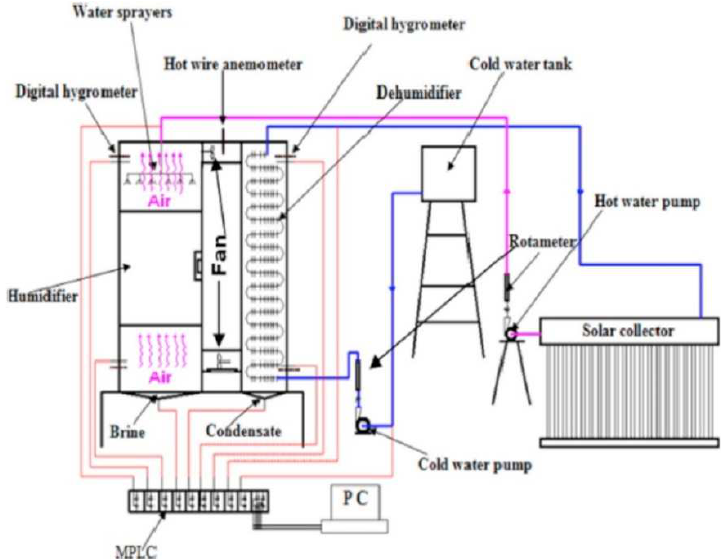
Figure 12. Desalination system based on OWCA including ETC. Reproduced with permission from A. E. Kabeel, Mofreh H. Hamed, Z. M. Omarab, S. W. Sharshirb, Eenergy Journal, published by Elsevier, 2014 [221].